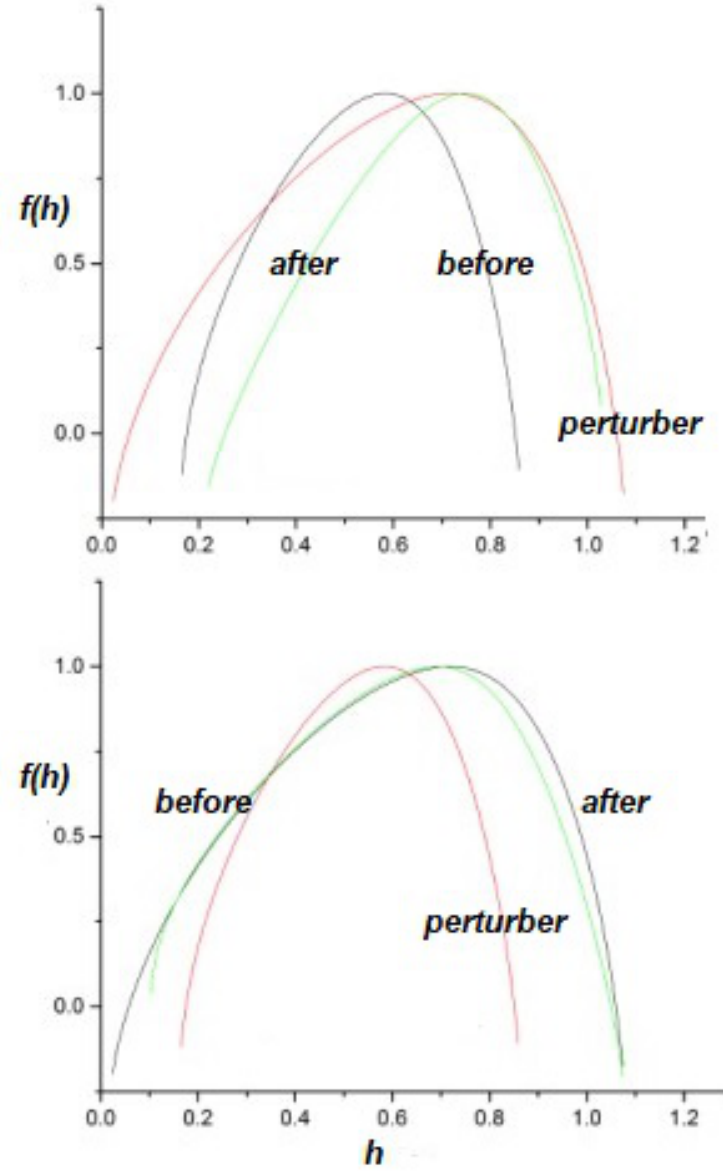
Figure 4. Effects of perturbation of network R by network P as captured by the multifractal spectrum. ( Upper ): the perturber network has µ P = 2.4 response network has µ R = 3.4 and is depicted before and after the perturbation; ( Lower ): the perturber network has µ P = 3.4 and response network has µ R = 2.4 and is depicted before and after the perturbation. The spectrum of the perturbed system is strongly affected in the first case in the upper panel, in contrast to the second case in the lower